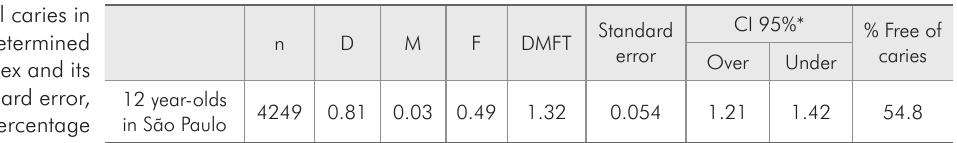
Table 1 - Mean dental caries in permanent dentition, determined by the DMFT index and its components, standard error, confidence interval and percentage of caries-free children